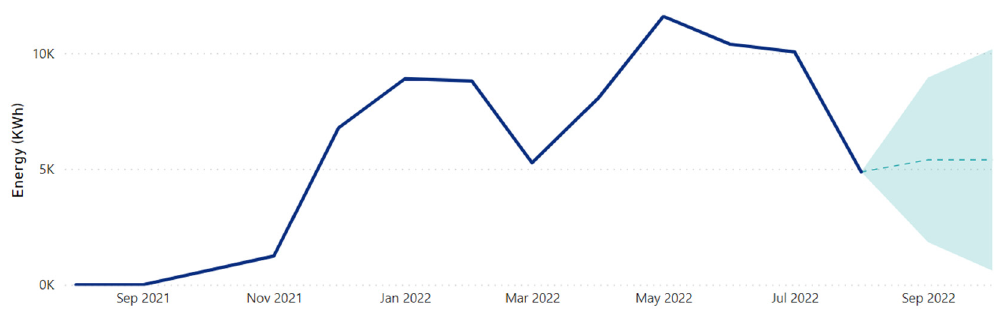
Figure 15. Energy consumption forecast for Operation 3.